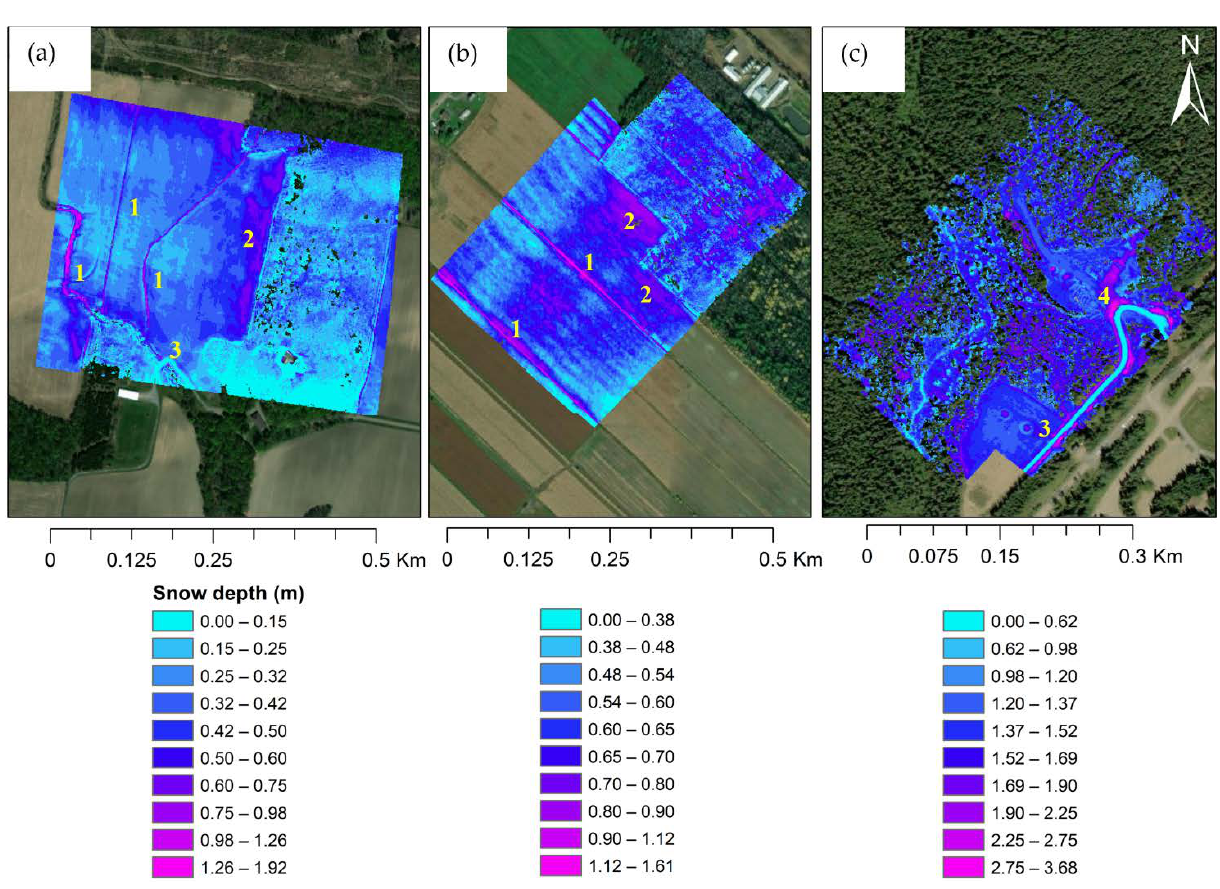
Figure 10. UAV lidar-derived snow depth maps. ( a ) Sainte-Marthe; ( b ) Saint-Maurice; and ( c ) Mont- morency. Features 1 to 4 are discussed in the text.